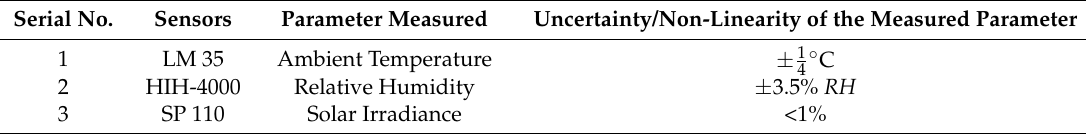
Table 1. Details of the sensors for collecting environmental parameters.